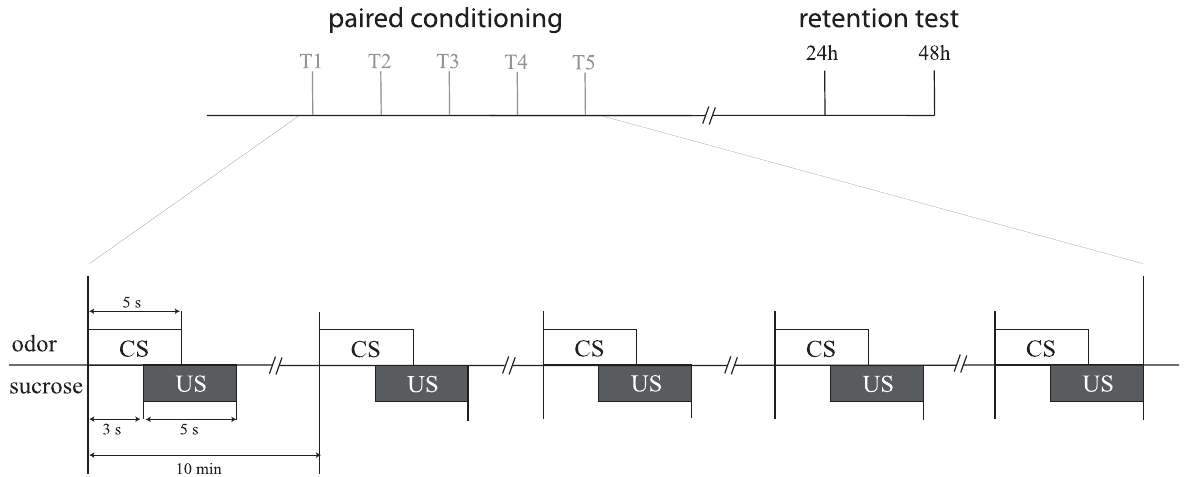
Fig 1. Olfactory classical PER conditioning protocol. Experimental procedure of paired group olfactory classical PER conditioning (inspired by Matsumoto et al. 2012). Lavender (conditioning stimulus, CS) was applied for 5s. After 3s, sucrose 50% (unconditioning stimulus, US) was presented. Each bee received five paired CS–US presentations (noted trial T1 to T5) with a 10 min inter-trial delay. Retention tests were performed 24 h and 48 h after the last conditioning trial and consisted of presentation of the CS without US.